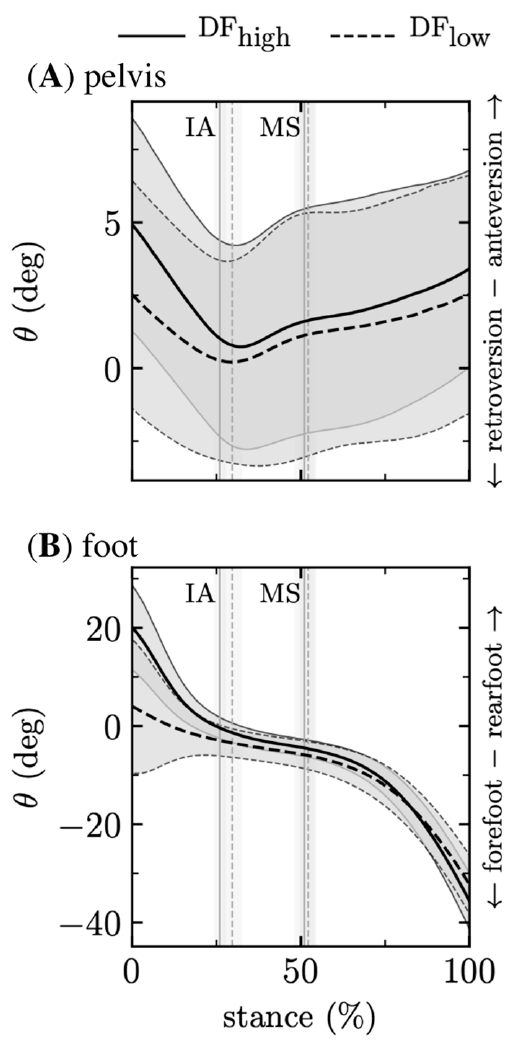
Figure 3. Segment angles ( θ ) during the running stance for the high (DF high ) and low (DF low ) duty factor running groups while running at 14 km/h for ( A ) pelvis (retroversion-anteversion) and ( B ) foot (forefoot–rearfoot) segment angle, expressed as a difference with respect to segment angle in the static upright stance. The running speed is representative of all speed. IA: impact attenuation, MS: mid-stance, rot: